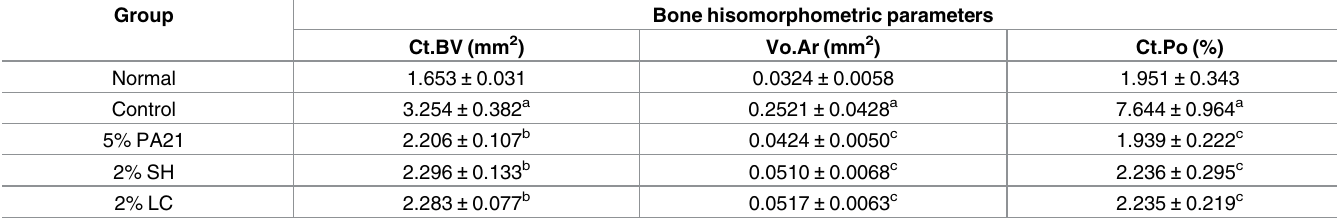
Table 5. Effects of PA21, sevelamer hydrochloride, and lanthanum carbonate hydrate on cortical bone histomorphometric parameters.